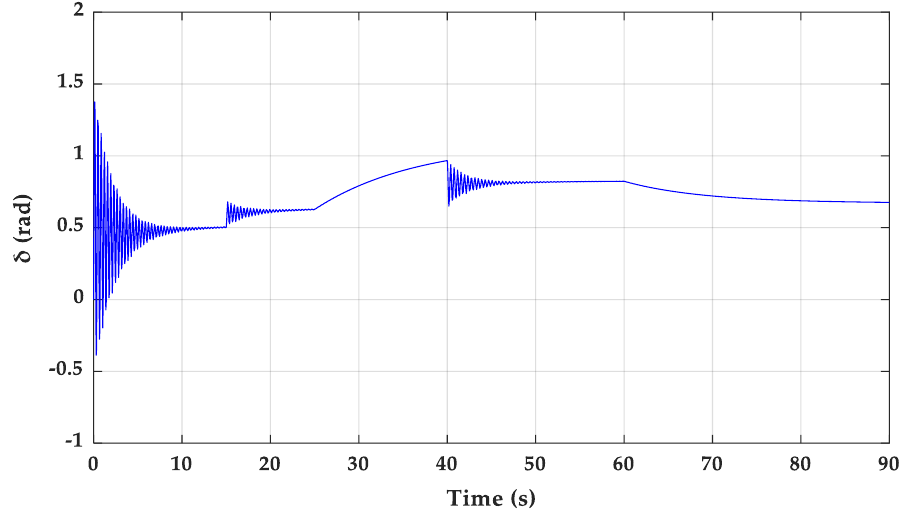
Figure 9. Angle response of the SGIB with feedback.